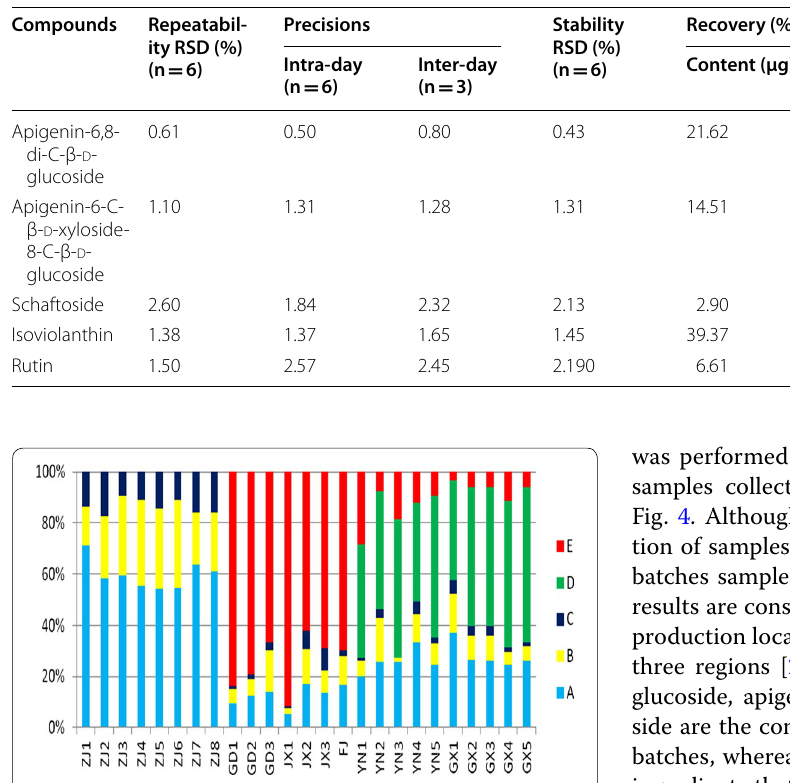
Sample quantitative analysis